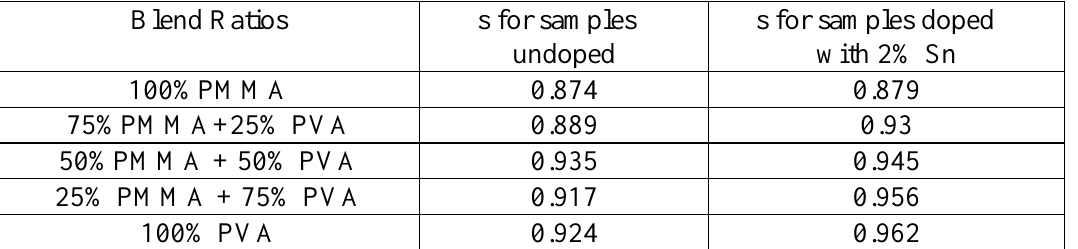
Table 2: s values of PMMA / PVA blends undoped and doped with 2%